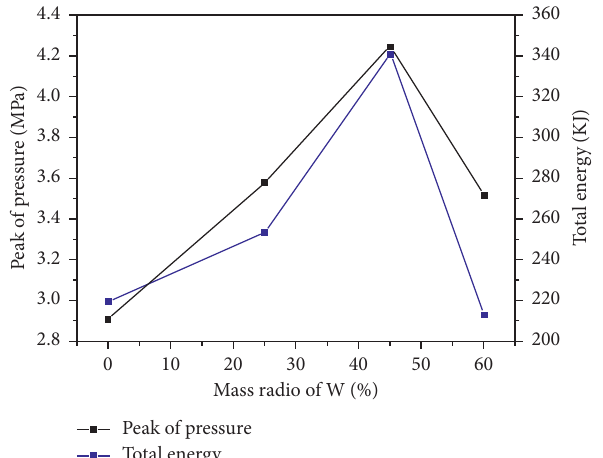
Figure 17: Comparison of the overpressure peak value and energy release value of energetic jets with different W contents.